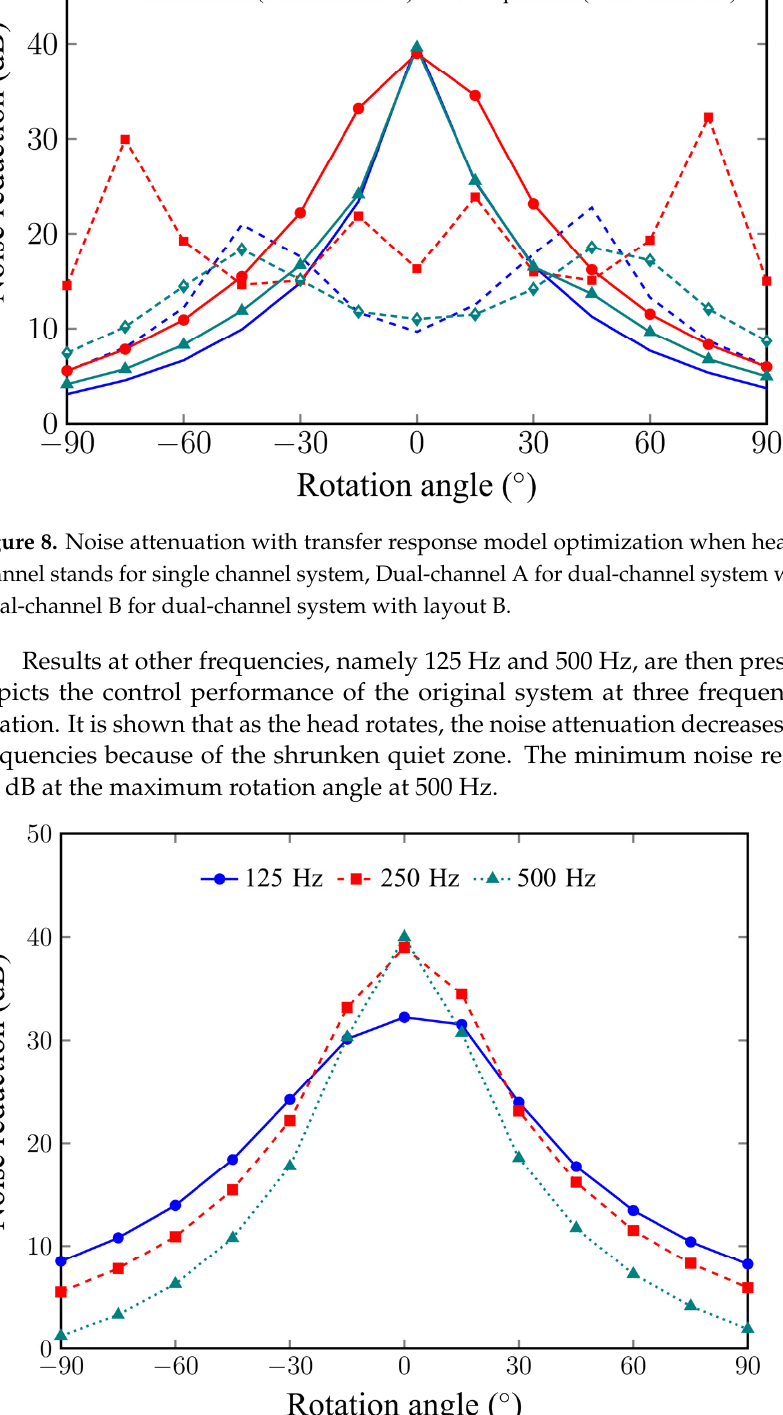
( b ) Figure 10. Noise attenuation at different frequencies when head rotates: ( a )125 Hz, ( b )500 Hz. 3.3. Influence of Different Parameters There are a few parameters that have an impact on the results of the transfer response model optimization method. Firstly, three types of transfer response model, whose varia- tion with head rotation has been analyzed in Section 3.1, may influence the noise reduc- tion performance, and the model of S v has been chosen for optimization. The optimization results with the model of S v optimized, the model of G optimized and the models of S v and G optimized simultaneously are presented in Figure 11a and it can be concluded that there is almost no difference between the three results. This can be explained by Equation (17), where the cost function is determined by 𝐒(cid:3552) (cid:2932) － (cid:2869) 𝐆(cid:3553) (cid:2925)(cid:2926)(cid:2930) when the transfer response S p